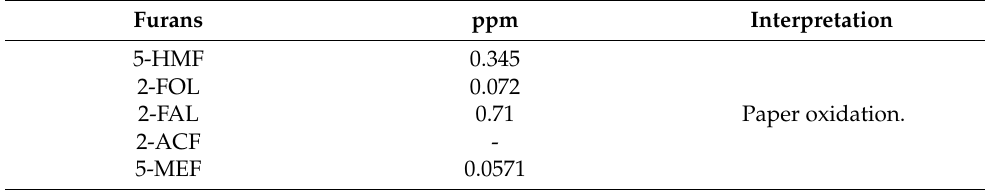
Table 15. Analysis of furans and their